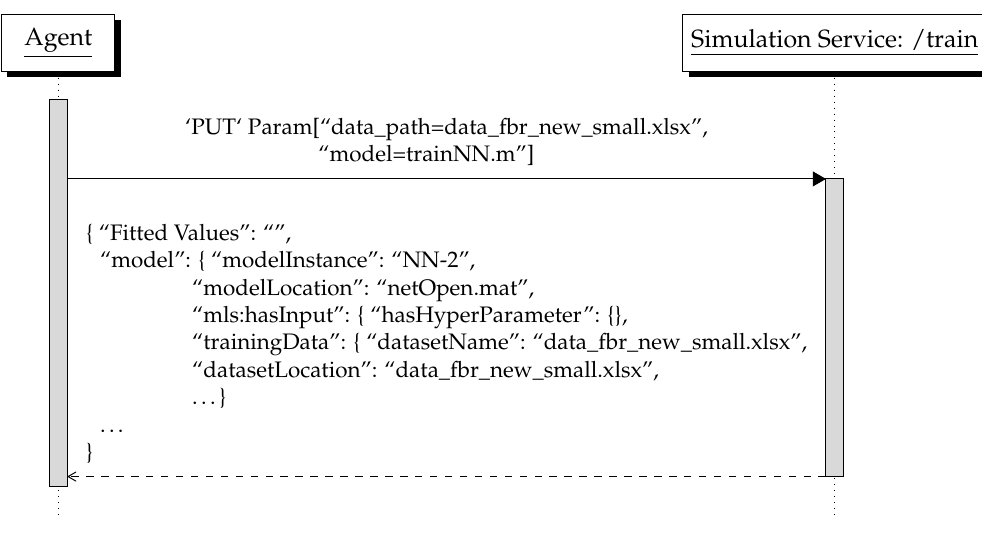
Figure 9. Sequence diagram for training a simulation model at the service endpoint.